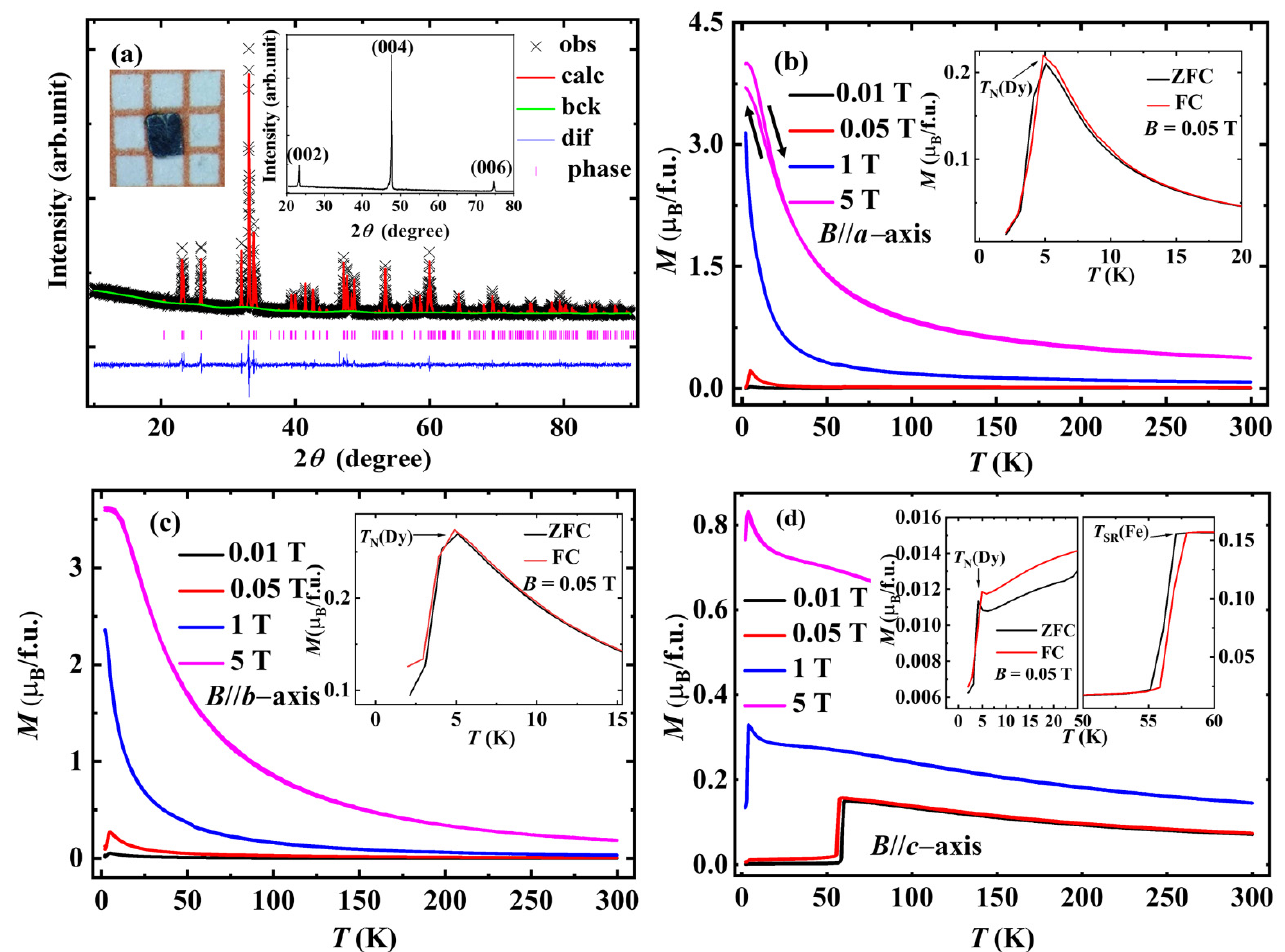
Figure 2. ( a ) The XRD patterns of DyFeO 3 powder and single crystal (right inset) and the DyFeO 3 single-crystal sample morphology (left inset). ( b – d ) The temperature dependence of the magnetiza- tion of the DyFeO 3 single crystal with magnetic fields along the a -, b -, and c -axes, respectively. The partial magnification near the transition temperatures of ZFC and FC curves measured at 0.05 T are shown in the corresponding insets.